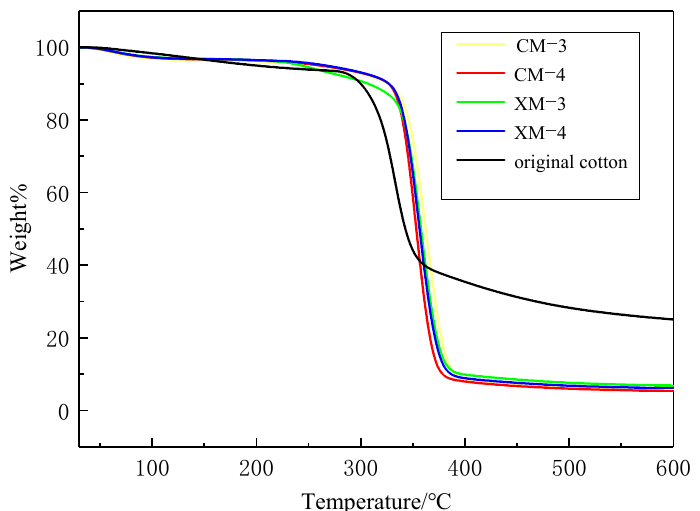
Figure 7. The TG curves of the original cotton fibers and the modified cotton fibers at different developmental stages from original cotton, CM-3, CM-4 and XM-3, XM-4 cultivar.